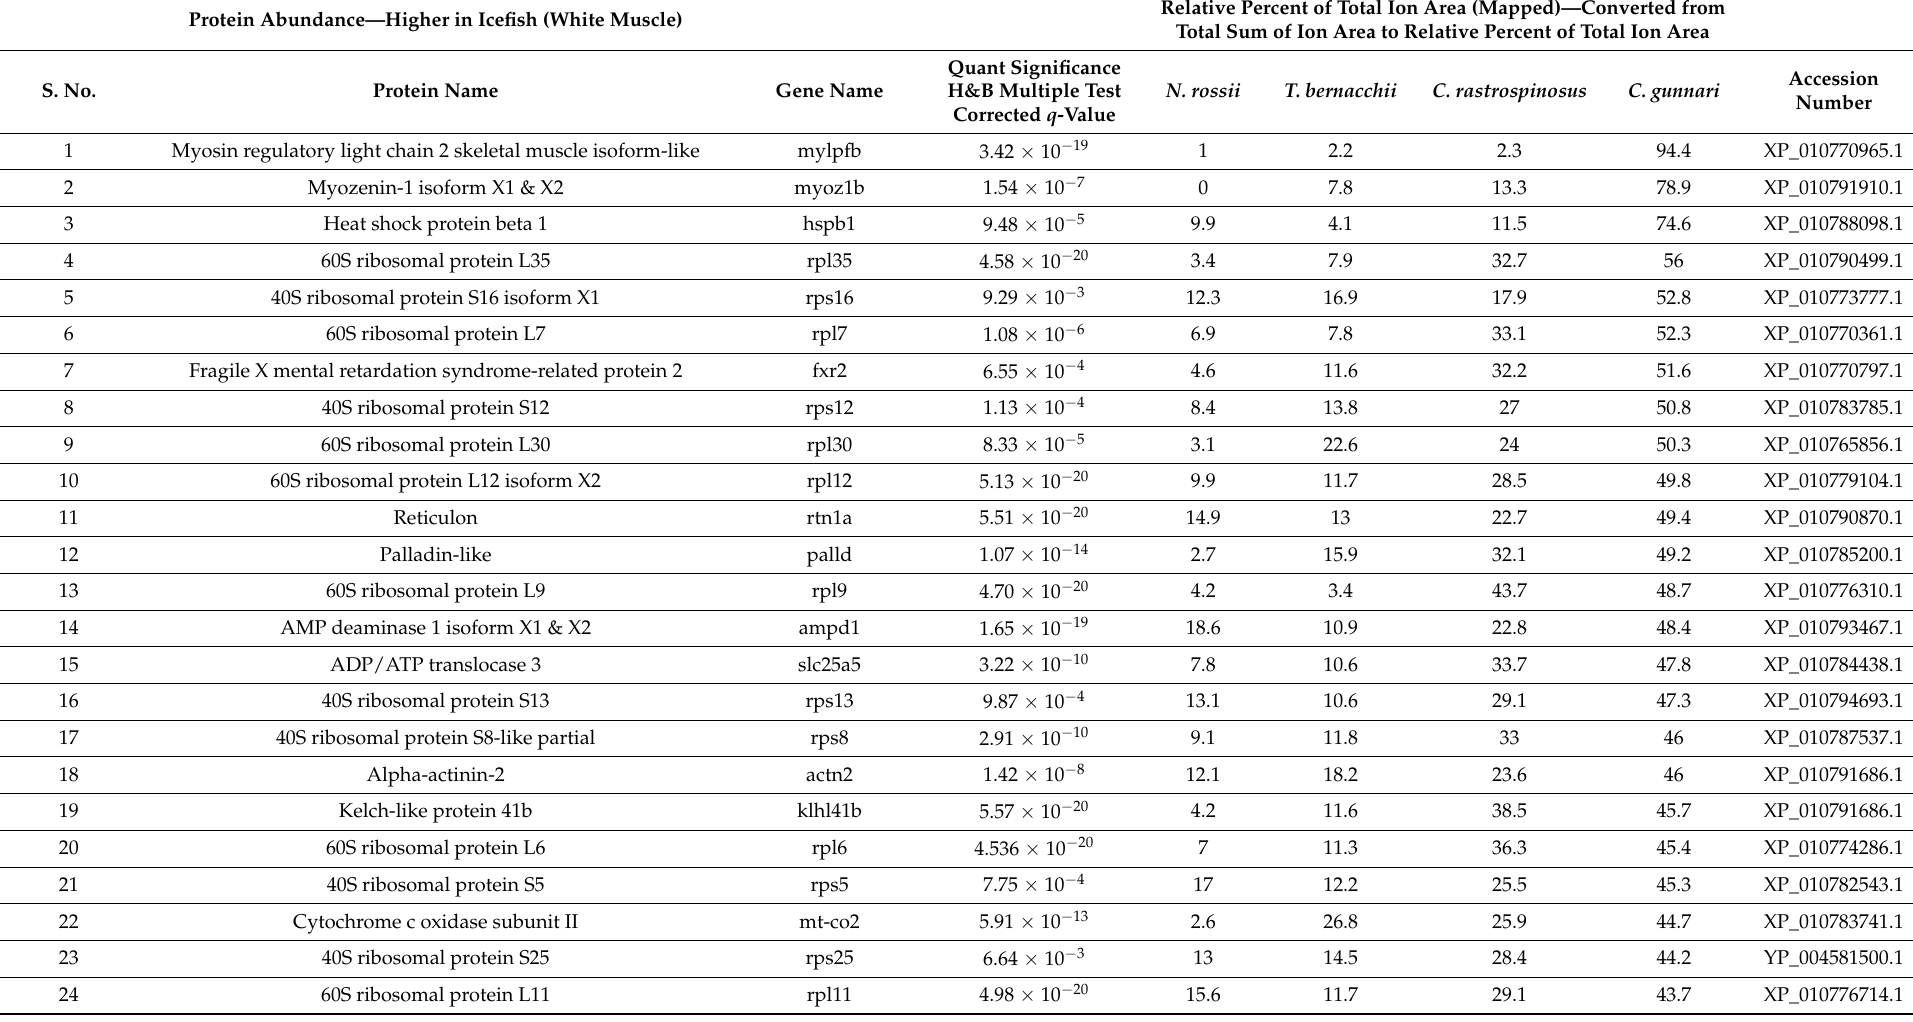
Table 2. DEPs between WMM with increased abundance in icefish specifically seen upregulated in icefish Champsocephalus gunnari . Protein Abundance—Higher in Icefish (White